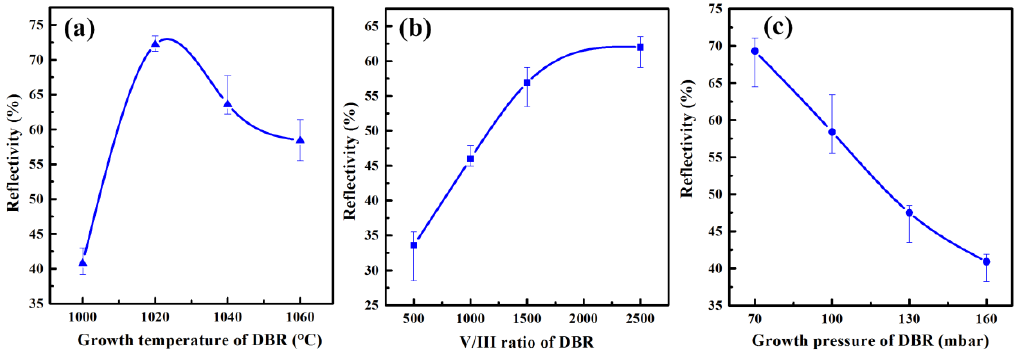
Figure 2. The reflectivity of the AlN/GaN DBR stop band of ( a ) series A, ( b ) series B and ( c ) series C.